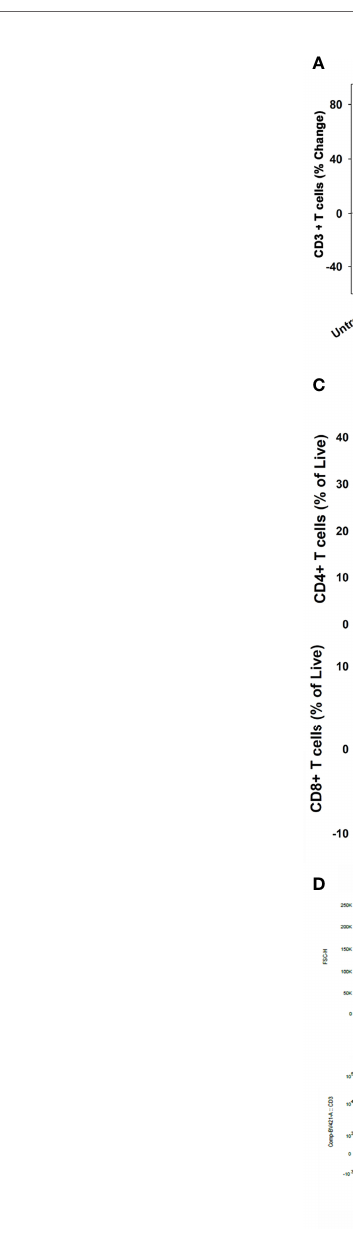
FIGURE 2 | Changes in the Number of Circulating CD3 + T Cells, CD4 + T Cells, CD8 + T Cells, DP Cells and Ratio of Circulating CD4/CD8 Cells in Mice Treated with Alphataxin. (A) Blood samples from healthy C57BL/6 mice treated for 2 weeks with Alphataxin (5 mg/kg) or vehicle control (DPBS) were analyzed by fl ow cytometry to detect circulating CD3 + T cells % change from baseline ( P < 0.05, n = 6) and CD4 + CD8 + DP cells % change from baseline ( P < 0.04, n = 6). In Alphataxin treated mice, CD4/CD8 ratios (% change from baseline) from healthy C57BL/6 male mice did not differ from those from tumor-bearing female BALB/c mice ( P = 0.589, n = 6 each). The mean % change from baseline was calculated as 100 x [(treatment mean-baseline)/baseline]. (B, C) In BALB/c mice orthotopically implanted with 5x10 3 Renca-GL cells, the changes in CD4 + and CD8 + T cell numbers between day 14 and day 21 of treatment for each animal is depicted. Circulating lymphocytes from the untreated ( ), Alphataxin-treated ( ), anti-PD-1 antibody-treated ( ), and combination-treated ( ) groups were enumerated by fl ow cytometry gated on live CD3 + T cells. After 21 days of treatment, the number of circulating CD4 + CD8 + DP cells was signi fi cantly greater in the combination treatment group than in the other treatment groups ( P = 0.002, n = 6/arm). After 21 days of treatment, the ratio of circulating CD4/CD8 cells was signi fi cantly increased in Alphataxin- and anti-PD-1- treated mice compared with the combination-treated and untreated mice ( P < 0.001, n = 6/arm). After 21 days of treatment, the number of CD4 + T cells were signi fi cantly increased in Alphataxin- and anti-PD-1-treated mice as compared with untreated mice ( P = 0.01 and P = 0.04, respectively, n = 6/arm). There was no change in the number of CD8 + T cells in any group ( P = 0.81). (D) An example of gating strategy from analysis of an animal in the combination treatment arm. The numbers of and % of lymphocytes were normally distributed, and differences among groups were tested by ANOVA and t-test. The CD4/CD8 ratios were not normally distributed, and differences were tested by Kruskal-Wallis one-way ANOVA on ranks. Means and standard deviations are shown. Asterisks designate statistically signi fi cant differences (* P <